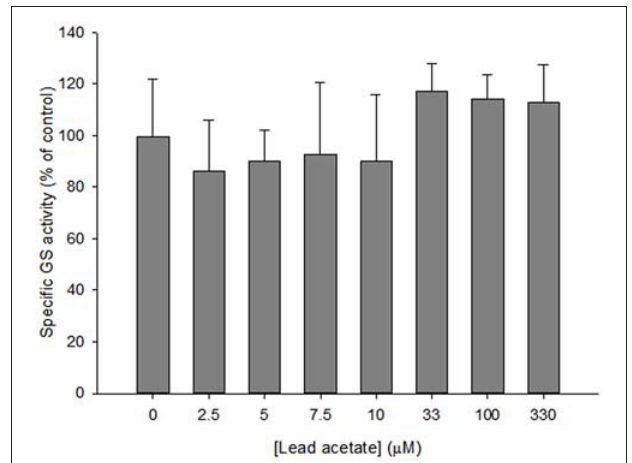
FIGURE 2 | Specific GS activity in astrocyte lysates incubated with 0–330 µ M lead acetate for 35 min. Bars show means ± SD of n = 6 samples. No significant difference was found between control and treated